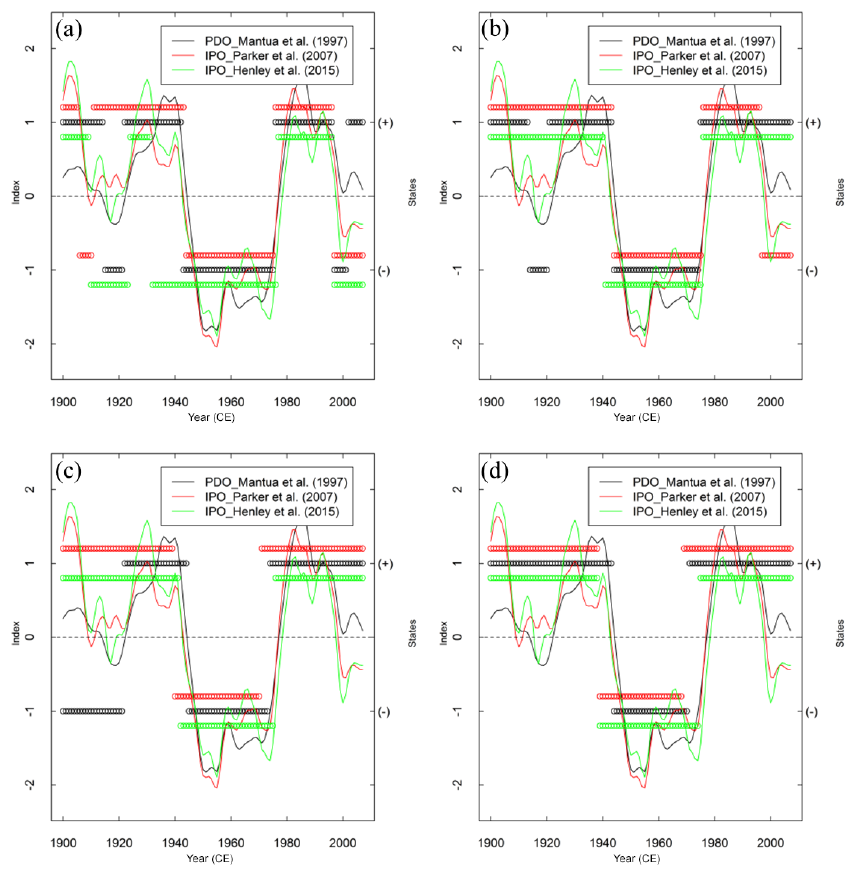
Figure 5. Time series plots of different instrumental PDV indices and corresponding run lengths (represented by dots in corresponding colour) extracted using different windows: (a) 10, (b) 20, (c) 30, (d) 40